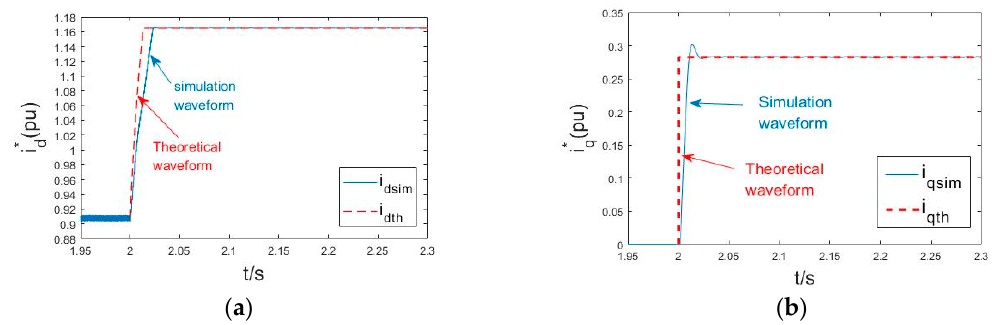
Figure 13. ( a ) Waveforms of d -axis output current. ( b ) Waveforms of q -axis output current.